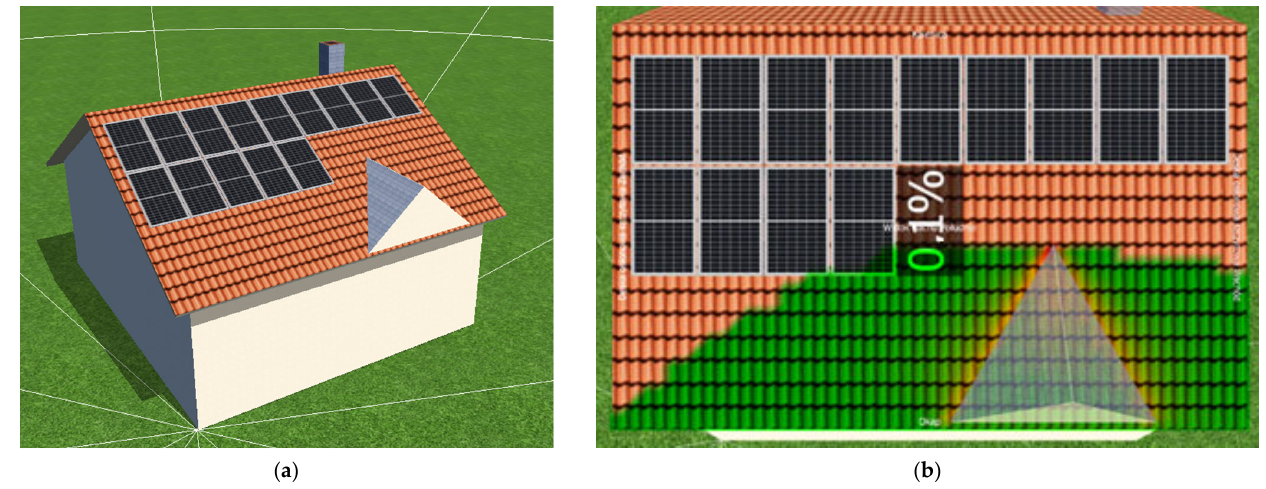
Figure 1. Visualisation of the PV installation on the roof of the building: ( a ) arrangement of panels, ( b ) analysis of the incidence of shadowing on PV modules.